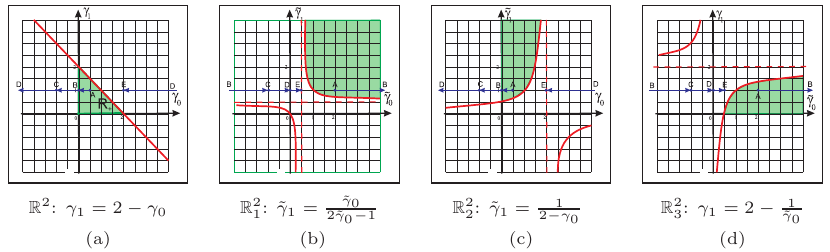
Figure 7. Characteristic Curve for integral nonlocal boundary conditions.